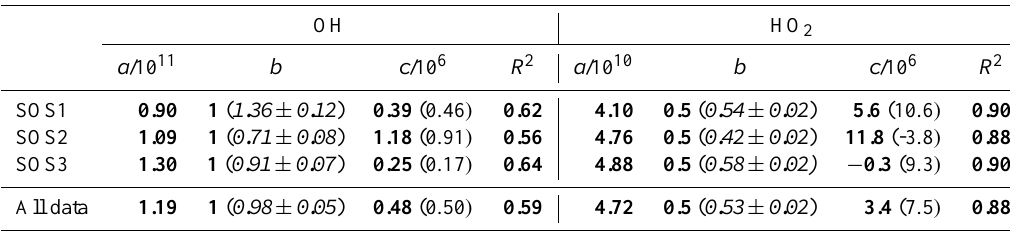
Table 3. Results of the analytical fits of Eq. (13) for J (O 1 D) to the observed five-minute averaged [OH] and four-minute averaged [HO 2 ]. The units of a are molecule cm − 3 s (for b = 1) and molecule cm − 3 s 1 / 2 (for b = 0 . 5), for OH and HO 2 , respectively. The units of c are molecule cm − 3 . For ease of comparison, the values displayed in bold are those for forced fits of b = 1 and b = 0 . 5 for [OH] and [HO 2 ], respectively; the values in parentheses are the results of unforced fits together with the standard errors on b . The values of R2 are virtually the same for the respective forced and unforced fits.